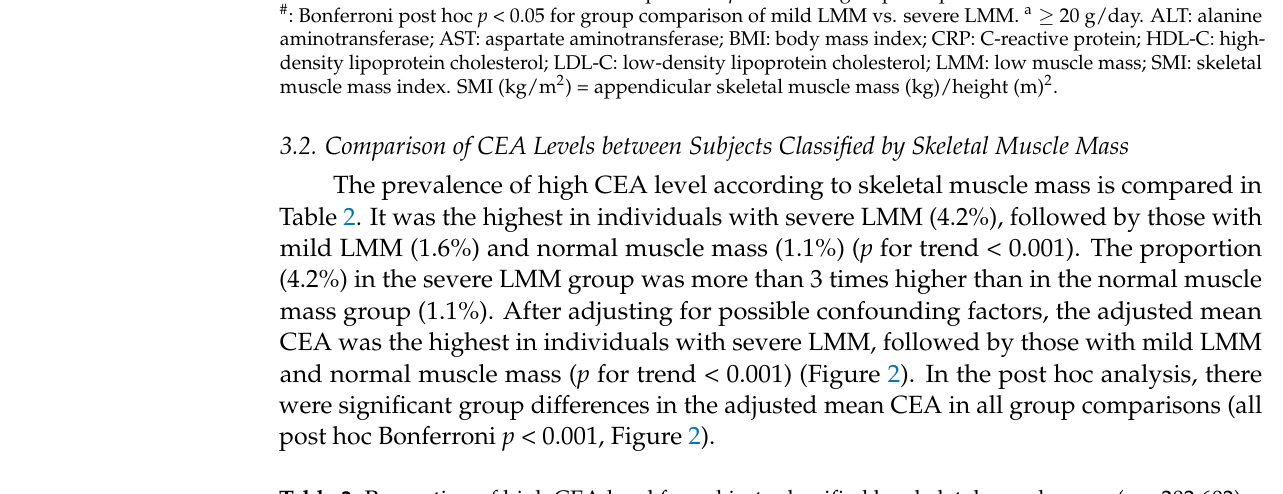
Table 2. Proportion of high CEA level for subjects classified by skeletal muscle mass ( n = 202,602).